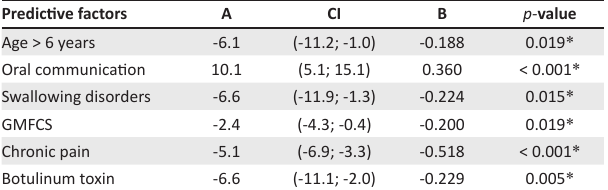
TABLE 5: The predictive factors of quality of life of children with cerebral palsy objectified by cerebral palsy-quality of life total. Predictive factors